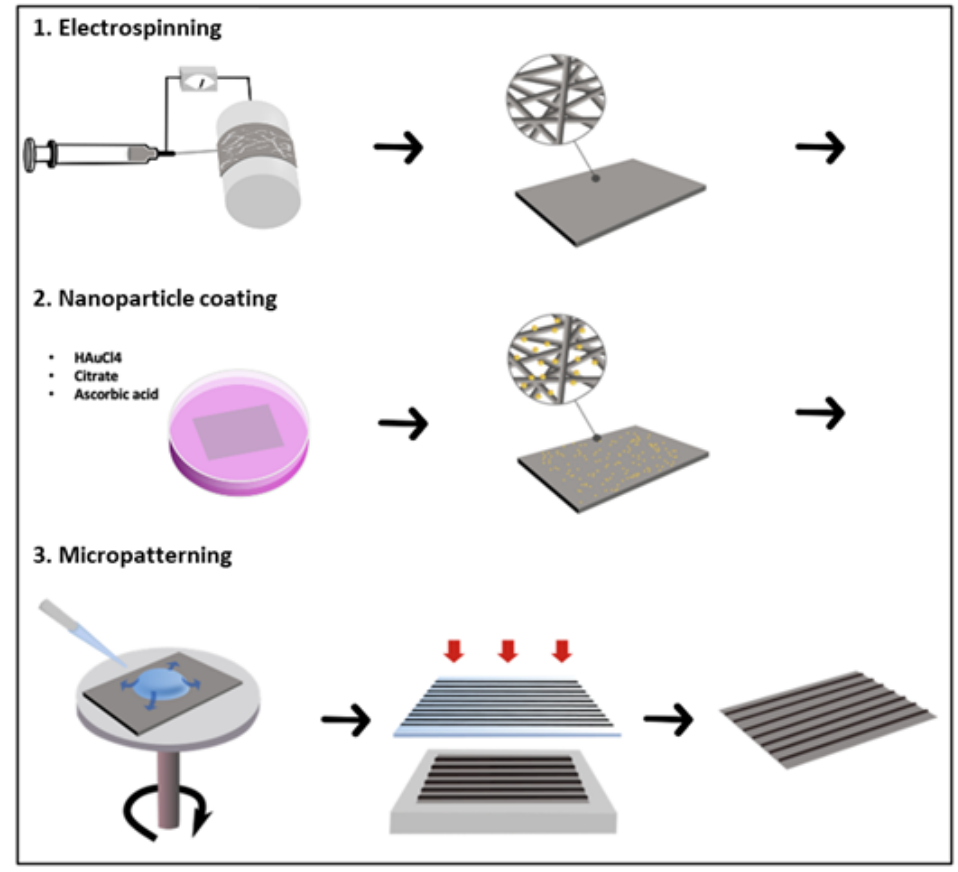
Figure 9. Schematic illustration showing the three steps in the manufacturing process: (1) electrospin- ning of PCL on drums at high velocity; (2) the nanoparticle coating process, including the successive addition of gold [HAuCl ], citrate, and ascorbic acid solutions to the scaffold immersed in milliQ 4 water; and (3) soft photolithography of polyethylene glycol (PEG) hydrogel, with 50 µm or 100 µm width line patterning and spaced 500 µm or 1000